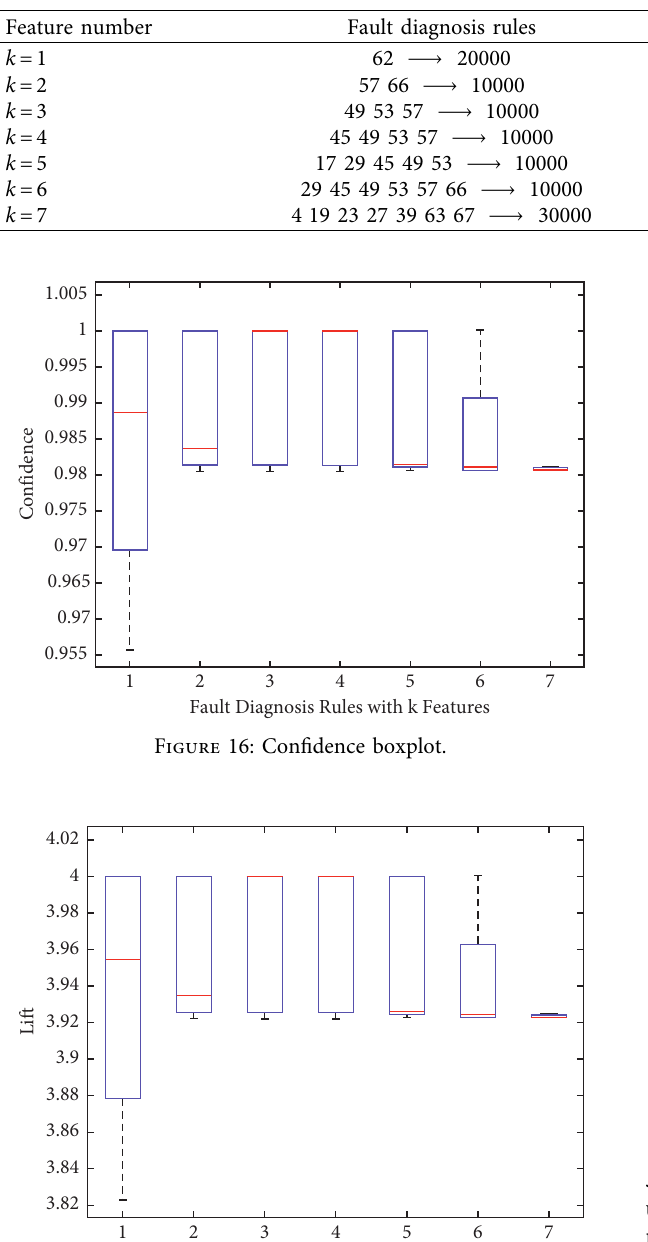
Table 4: Fault diagnosis rules with the highest confidence.